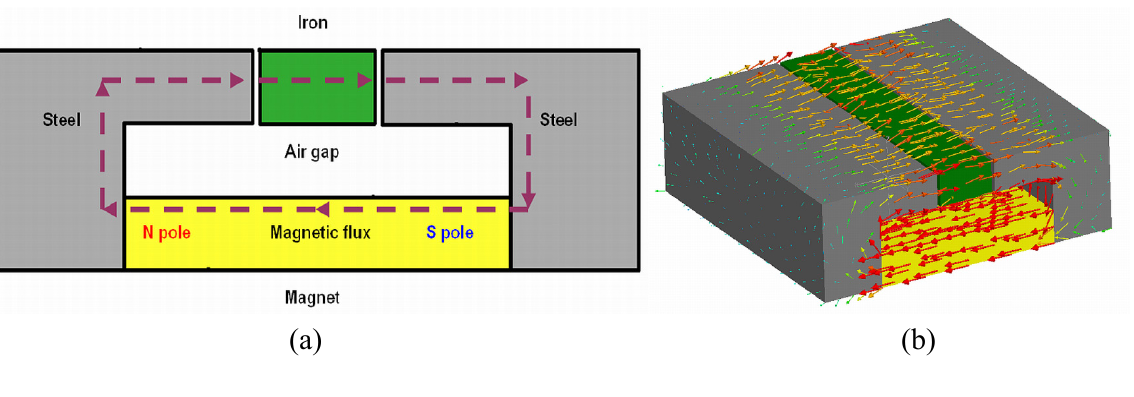
Figure 2. Schematic representation of the magnetization process: (a) 2D plot; (b) 3D